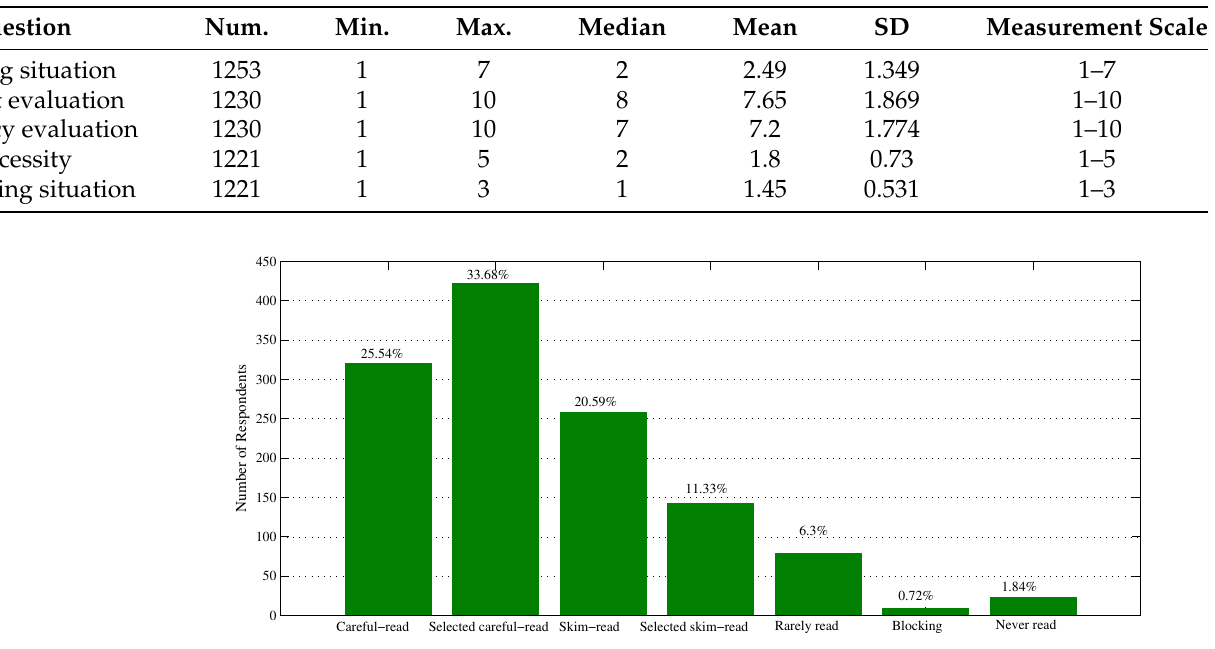
Table 3. Participants’ comments on public-interest